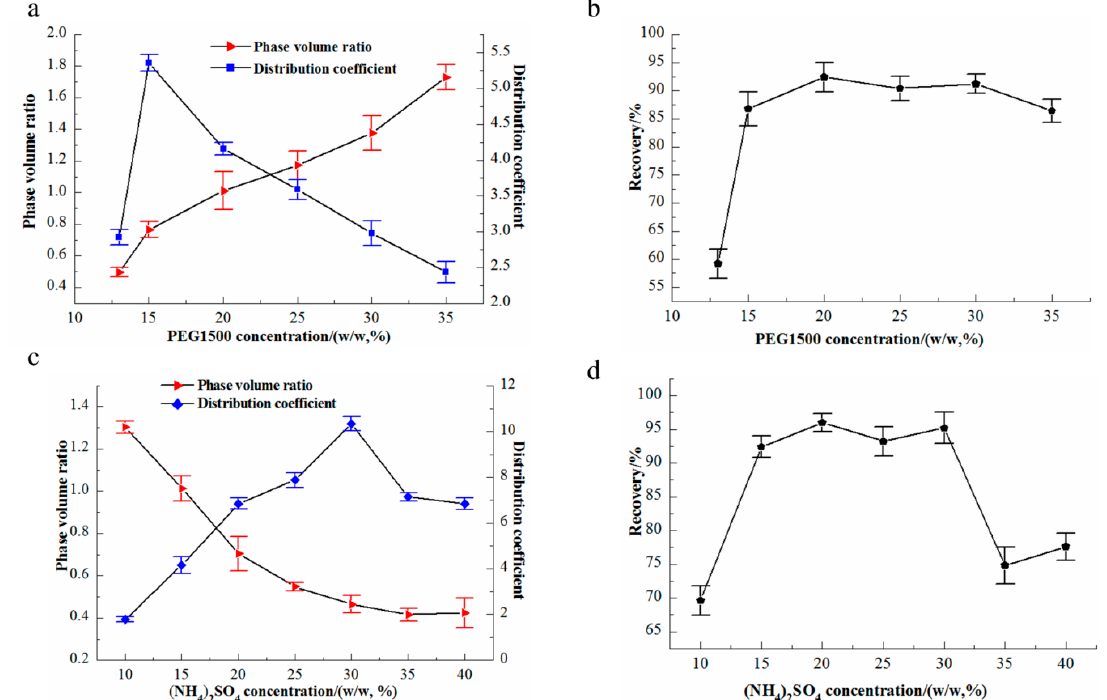
Figure 3. Effects of polyethylene glycol (PEG) and (NH 4 ) 2 SO 4 concentrations on partition coefficient and recovery of flavonoids in an aqueous two-phase system. ( a ) The effects of PEG1500 on the phase-volume ratio and partition coefficient, ( b ) the effects of PEG1500 on recovery of flavonoids, ( c ) the effects of (NH 4 ) 2 SO 4 on the phase-volume ratio, ( d ) the effects of (NH 4 ) 2 SO 4 on recovery of flavonoids.